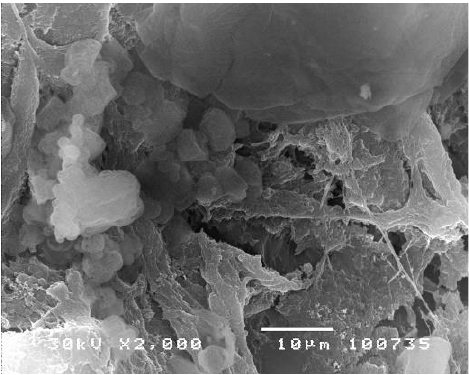
Figure 2. Tissue remains on soft dental acrylate polymer [43].